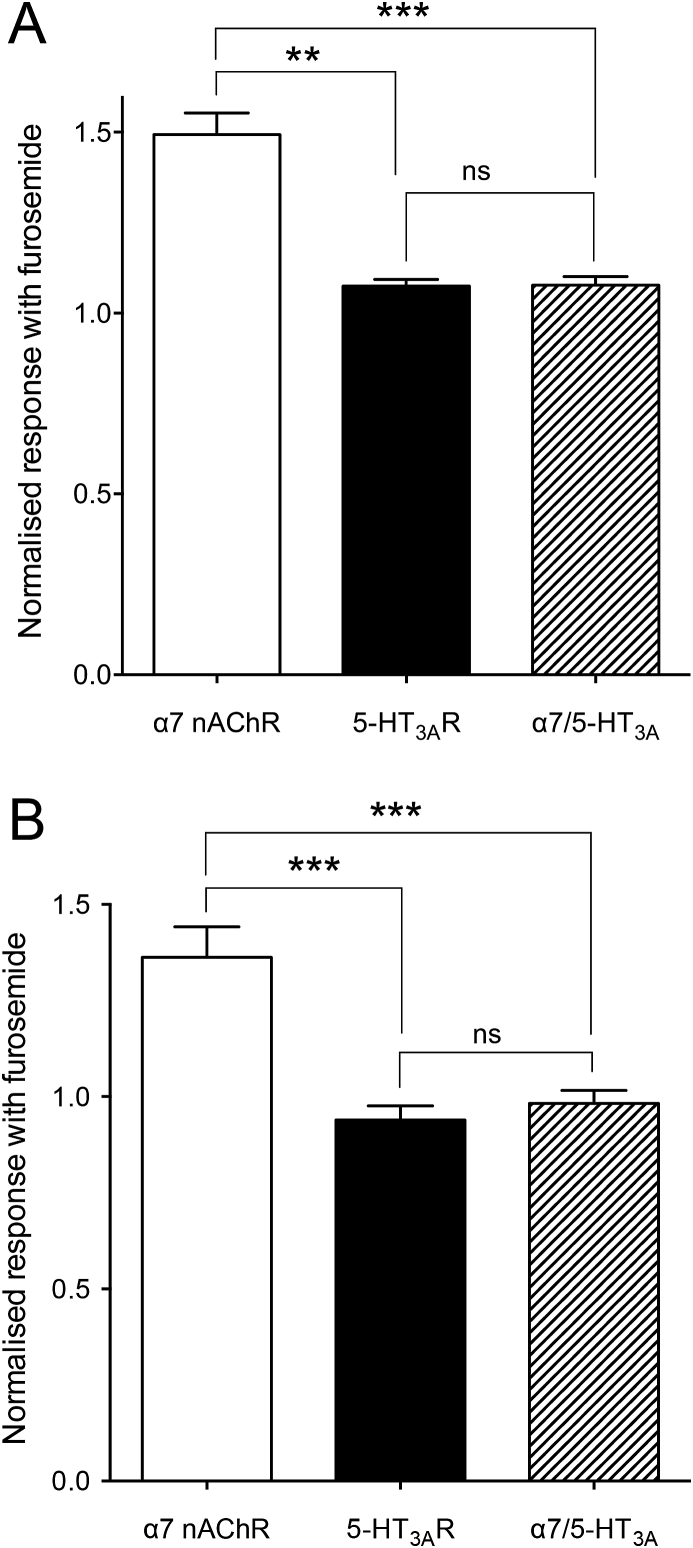
Functional characterisation of furosemide on α7 nAChR, 5-HT3AR and an α7/5-HT3AR chimera. The effect of furosemide was examined with either a maximal or an EC50 concentration of agonist (A and B, respectively). A) Furosemide (1 mM) was pre- and co-applied with a maximal concentration of agonist (3 mM ACh for α7 and α7/5-HT3AR chimera; 30 μM 5-HT for 5-HT3AR). B) Furosemide (1 mM) was pre and co-applied with an EC50 concentration of agonist (100 μM ACh for α7 and α7/5-HT3AR chimera; 1 μM 5-HT for 5-HT3AR). In both cases potentiation of the α7 nAChR was significantly greater than potentiation with the 5-HT3AR and with the α7/5-HT3A chimera. Data are means ± SEM (n = 4–8). Significant differences are indicated (**P < 0.01, ***P < 0.001).